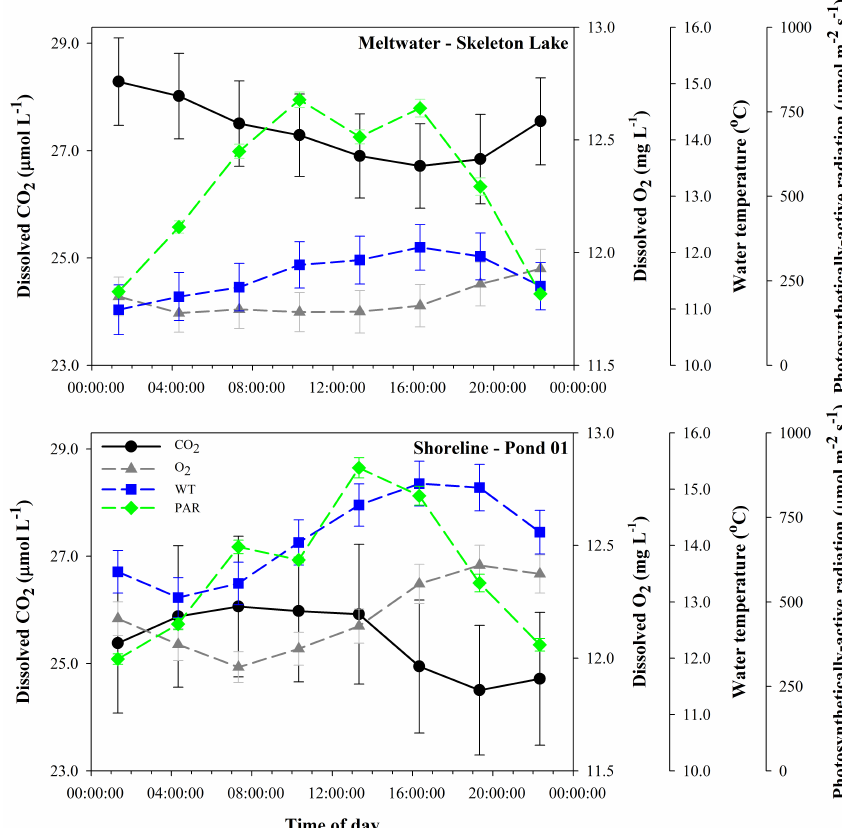
Figure 4. Mean ( ± SE) of 3h diel dissolved carbon dioxide (CO 2 ) concentration, oxygen (O 2 ) concentration, water temperature, and pho- tosynthetically active radiation (PAR) data measured by automated systems deployed at the shorelines of Skeleton Lake (2008–2010) and pond 01 (2008–2010) during the high Arctic growing season (June–August) in the Lake Hazen